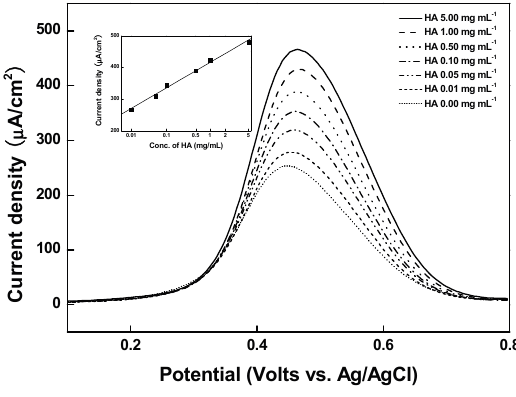
Figure 6. Differential pulse voltammograms of the SPCEs/Organic film/Ni/Fe-HA with variable HA (0 ~ 5 mg mL − 1 ). Inset shows the calibration curve of the anodic DPV peak current of SPCEs/Organic film/Ni/Fe-HA at 0.45 V versus Ag/AgCl as a function of the HA concentrations (N = 6, r =